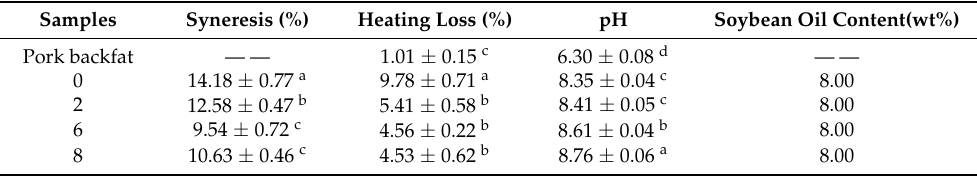
Table 1. Syneresis (%), heating loss (%), soybean oil content (wt%) and pH of pork backfat (PBF) and konjac emulgel-based fat analogue (KGFA) with different ethanol content after freeze-thaw treatment. Samples Syneresis (%)